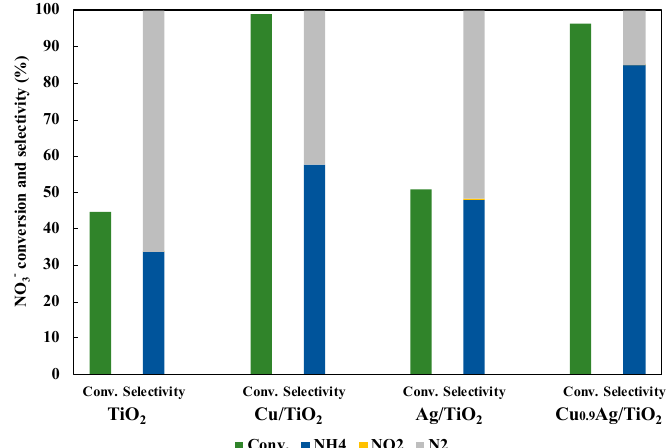
Figure 6. Comparison of photocatalytic activity over TiO 2 , Cu / TiO 2 , Ag / TiO 2 and Cu 0.9 Ag / TiO 2 in 45 mL of 50 ppm NO 3 − aqueous solution including 10 vol% CH 3 OH under UV irradiation for three hours. The loading amount of each samples was 30 mg. Left bar is NO 3 − conversion, right bars (blue, yellow, and gray) are product selectivity (NH 4 + , NO 2 − , and N 2 product, respectively).